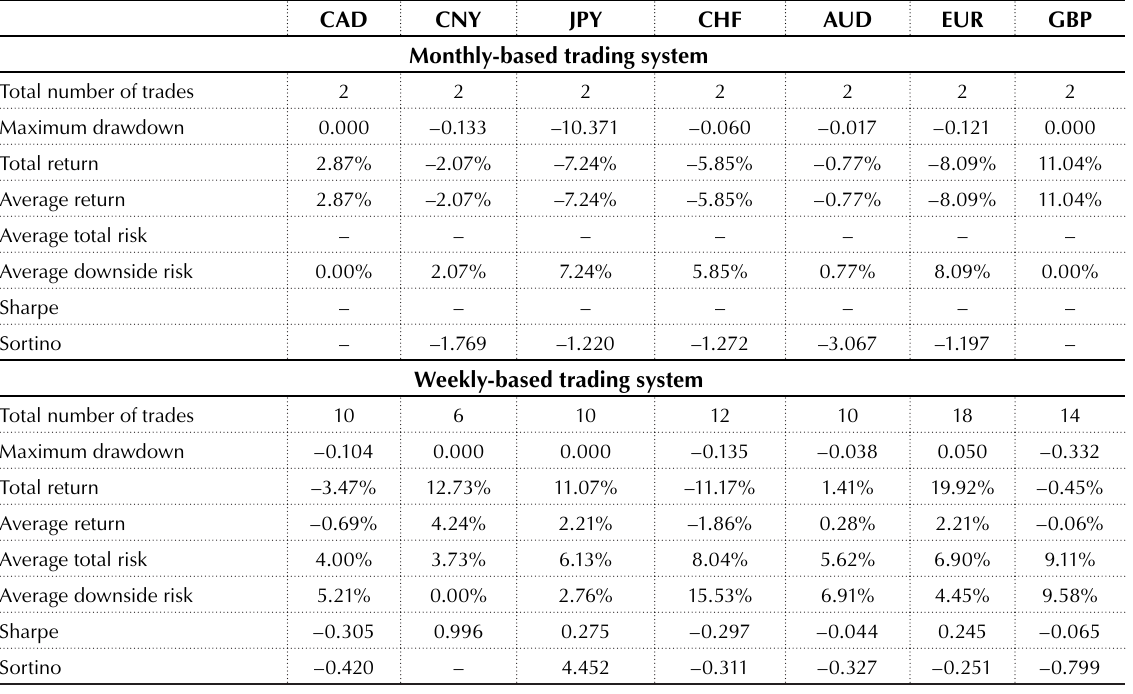
Table 3. Post 2008 financial crisis